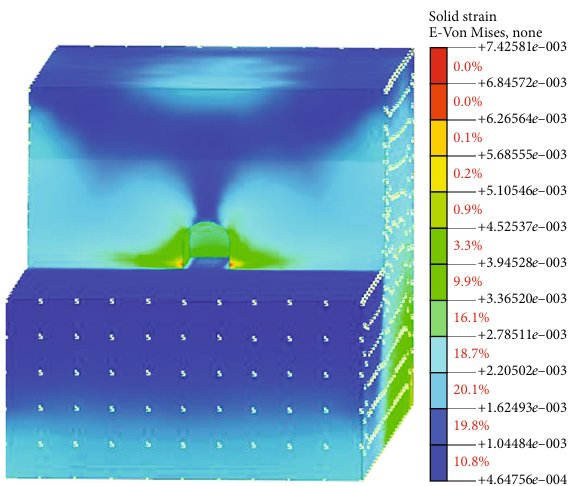
Figure 12: Von Mises strain nephogram under 0.05g.